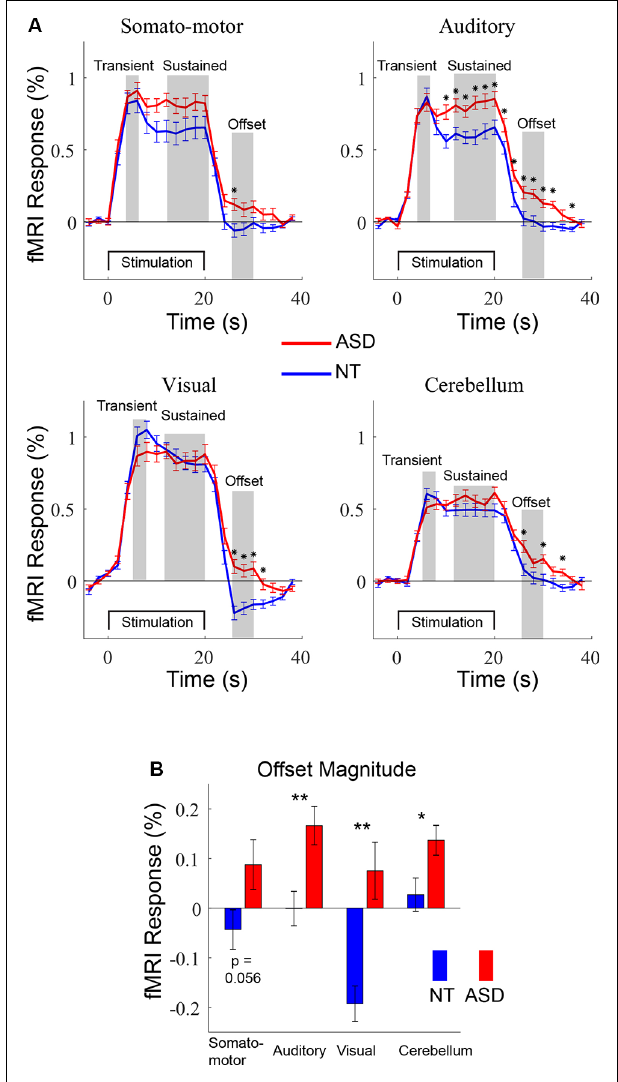
FIGURE 2 | (A) Averaged fMRI timecourses in four regions-of-interest (ROIs) for ASD (red) and NT (blue) participants. The time courses were used to guide the definition of three response windows: transient, sustained, and offset. (B) Offset magnitudes for NT and ASD participants in the four ROIs. * p < 0.05. ** p < 0.01; error bars =